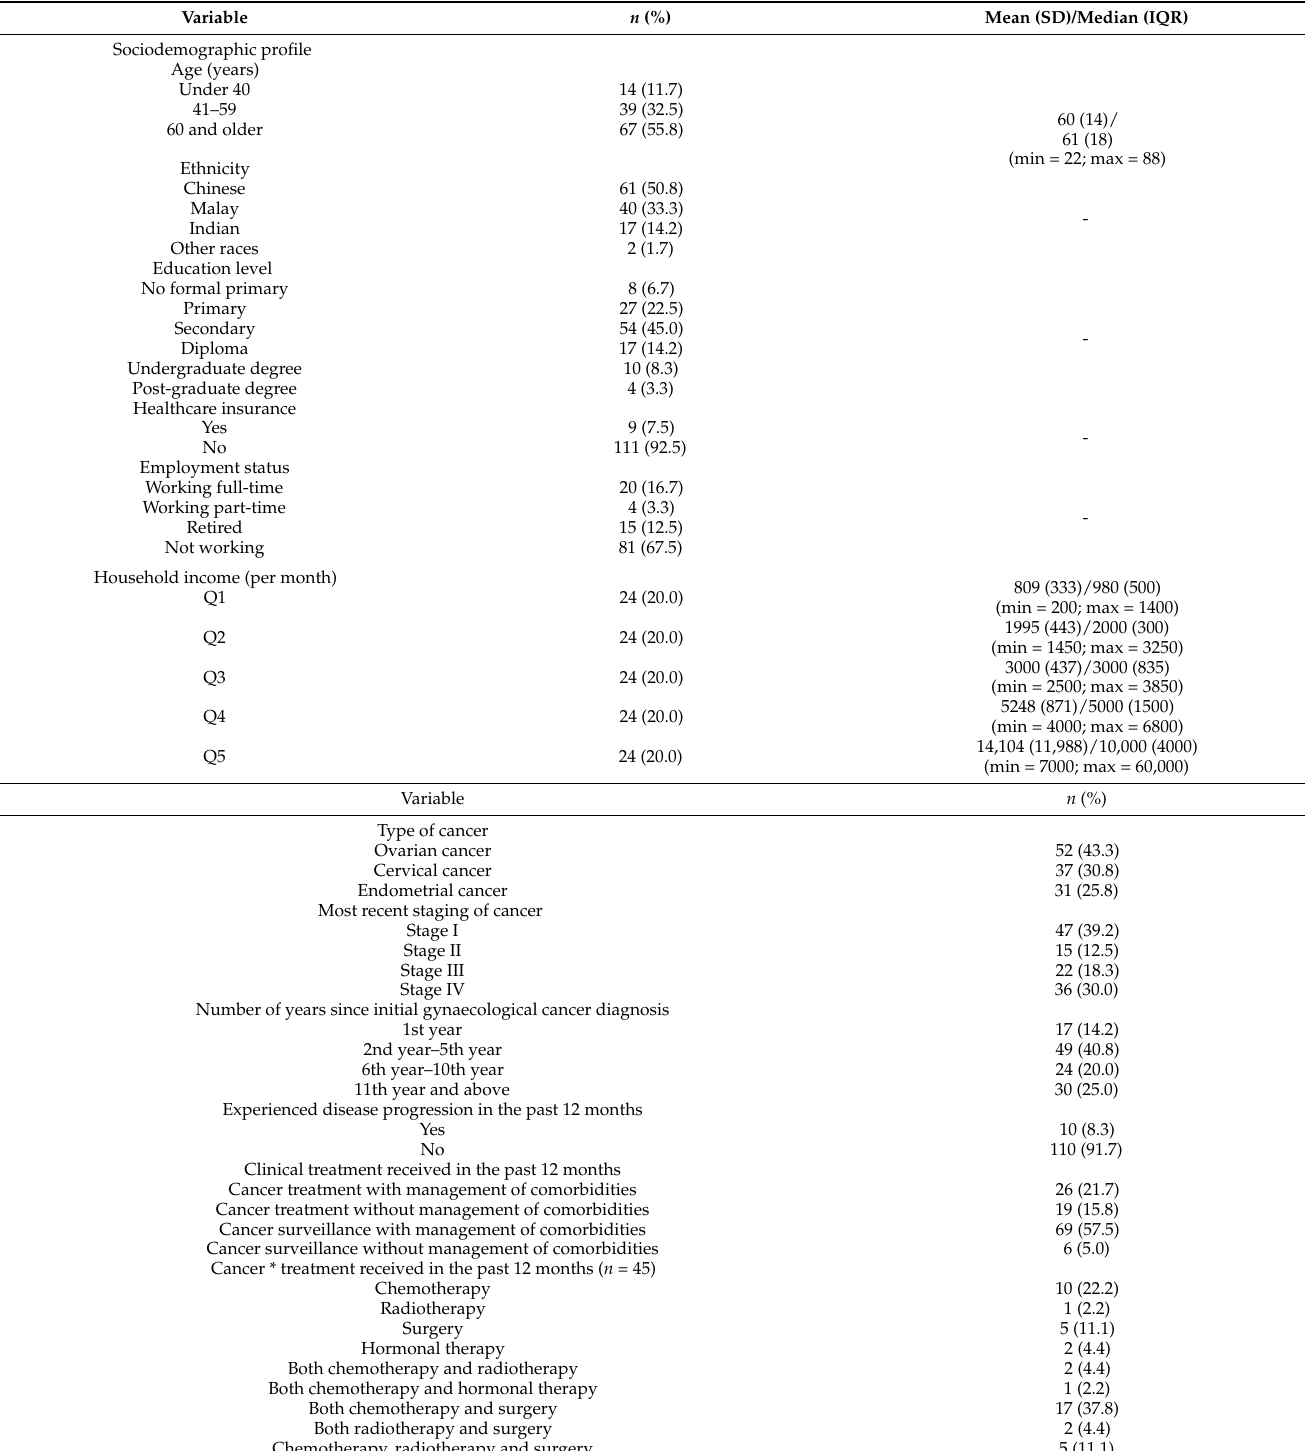
Table 1. Sociodemographic and clinical characteristics of the study population ( N =